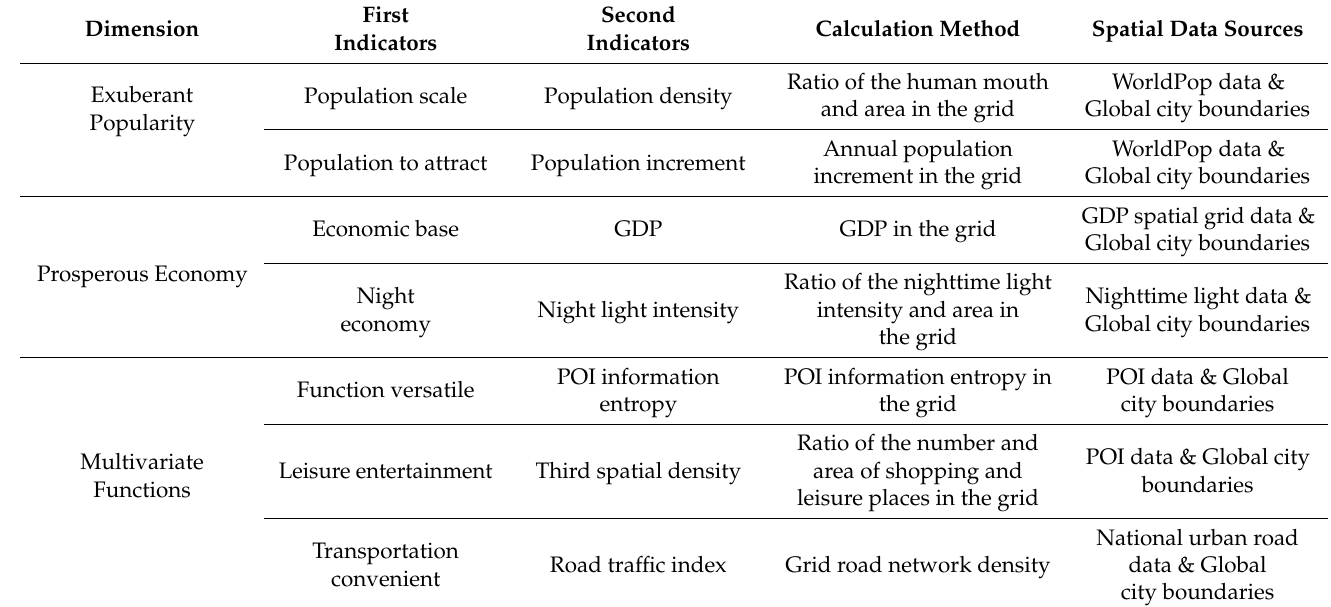
Table 3. Index system of urban vitality at grid